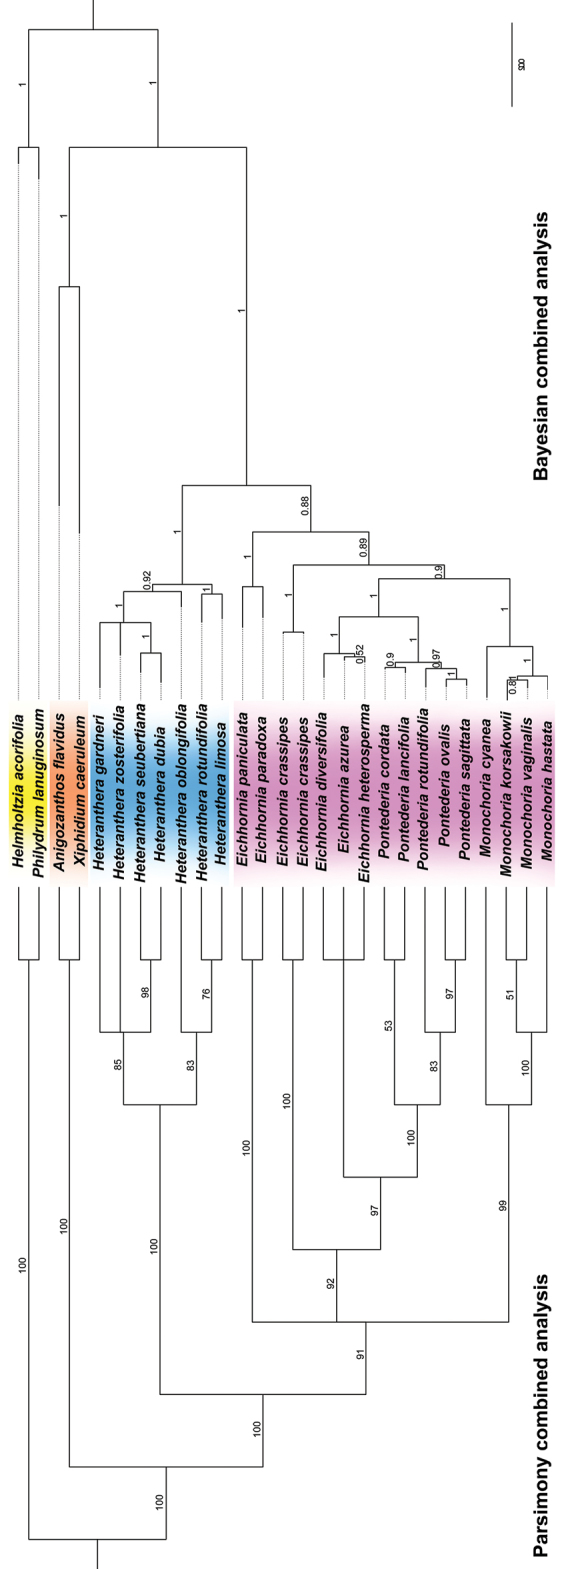
Majority-rule tree recovered for the parsimony and Bayesian analysis of the combined morphological + plastid dataset. Yellow: Philydraceae. Orange: Haemodoraceae. Blue: Heterantheras.l. Pink: Pontederias.l.